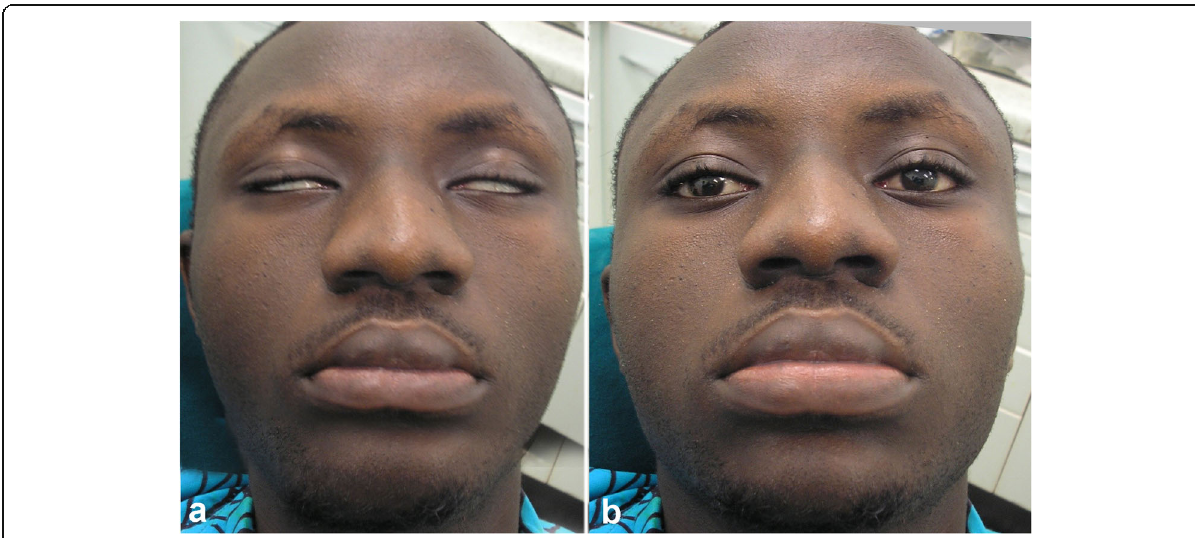
Fig. 1 Oculogyric crisis in a patient who exhibited paroxysmal, conjugate, tonic, ocular deviations caused by sustained contractions of the ocular muscles ( a ). The patient without symptoms following treatment ( b